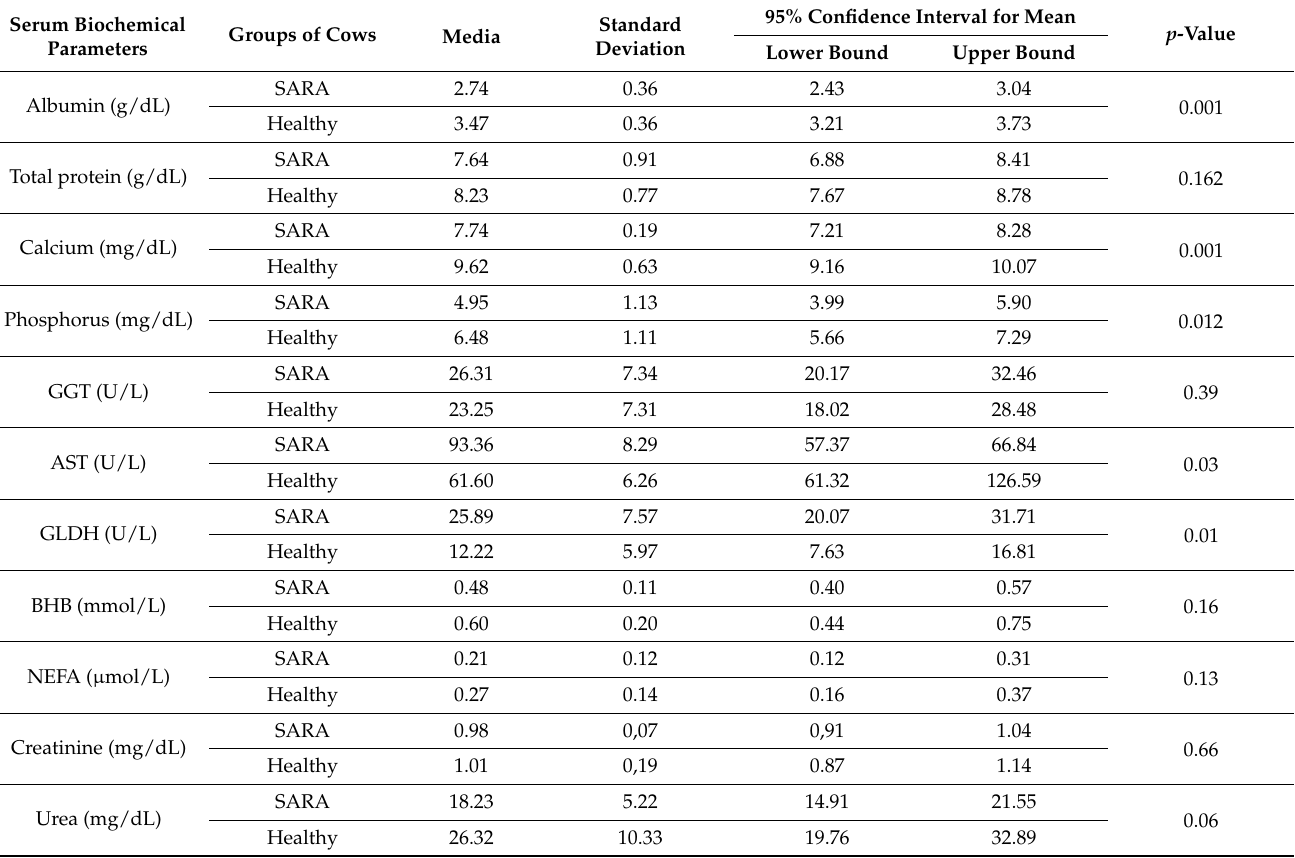
Table 2. Results of ANOVA comparing least square mean of serum biochemical parameters between SARA and healthy